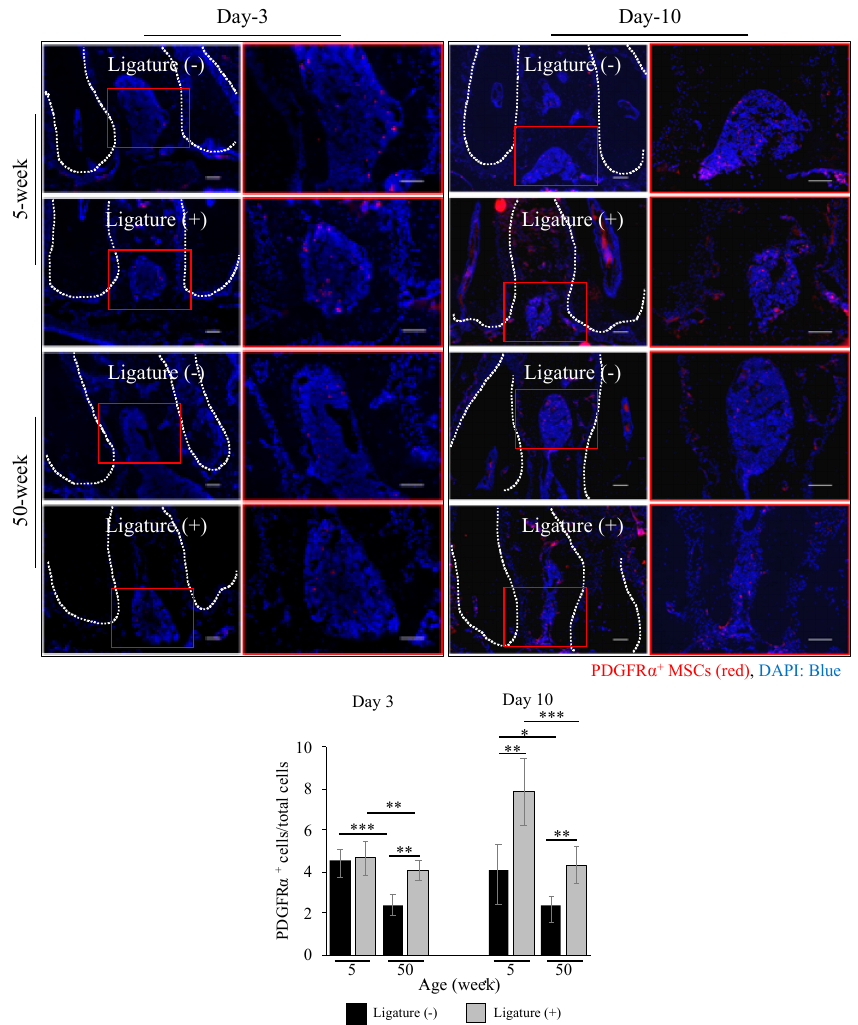
Figure 4. Reduced number of MSCs at the periodontitis site in aged mice. Immunofluorescence images show the number of platelet-derived growth factor receptor α (PDGFR ⍺) + MSCs (red) in the furcation area in young and aged mice. Cell nuclei were stained with DAPI (blue). Bar: 100 µm. The graph shows the quantitative analysis indicating that the number of PDGFR ⍺ + Mesenchymal stem cells (MSCs) is decreased in aged mice, more prominently at day-10 after ligation. The bar graph represents the mean ± standard deviation of at least three independent samples. * p < 0.05, ** p < 0.01, *** p < 0.001, two-way ANOVA, Tukey test ( n =